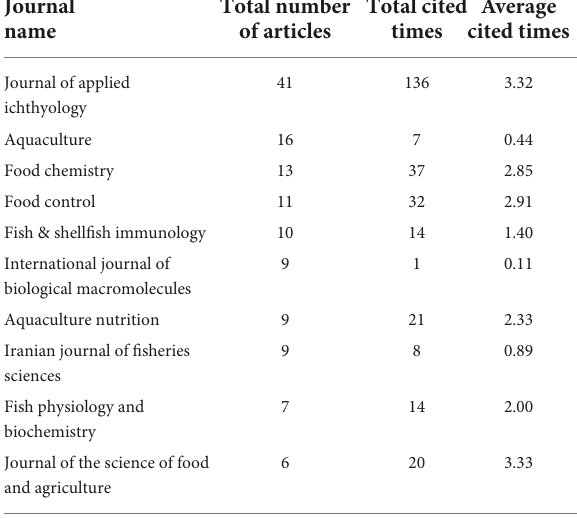
TABLE 2 Journal statistics of articles published from 2010 to